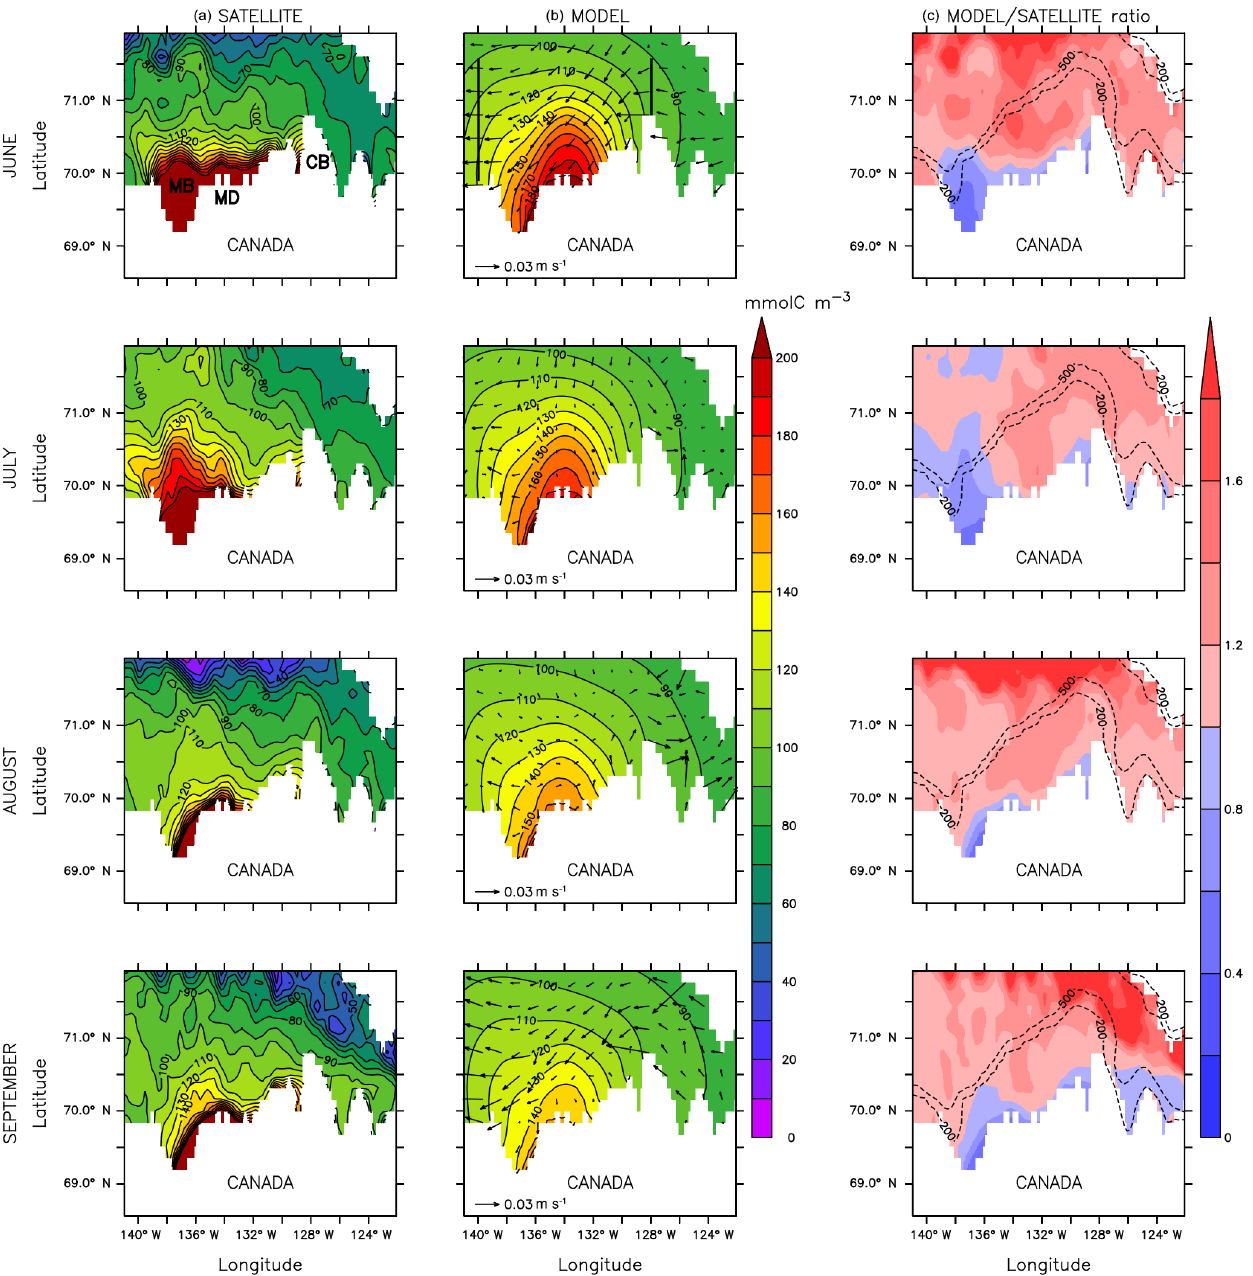
Figure 2. Monthly climatology (2003–2011) of surface tDOC concentration (mmolCm − 3 ) in the Beaufort Sea estimated from remotely sensed ocean color data (a) and by the biogeochemical model (b) for June, July, August, and September. Mackenzie Bay (MB), Mackenzie Delta (MD), and Cape Bathurst (CB) cited in the text are shown in the upper left panel. The isolines of tDOC concentration are overlaid (black full lines). In (b) , simulated surface currents (ms − 1 ) are overlaid. The two straight lines in the upper-middle panel refer to transects along which surface tDOC fluxes were computed. Panel (c) shows the model over satellite tDOC data ratio with the 200 and 500m isobaths